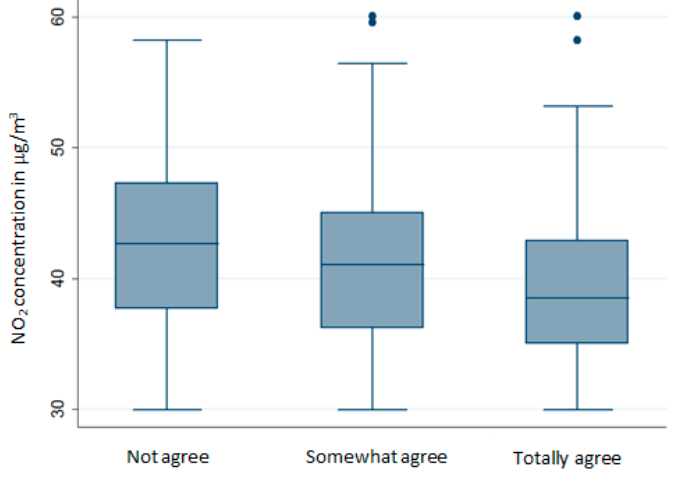
Figure 7. Distribution of NO 2 concentrations according to the level of satisfaction with air quality at census block census block level.